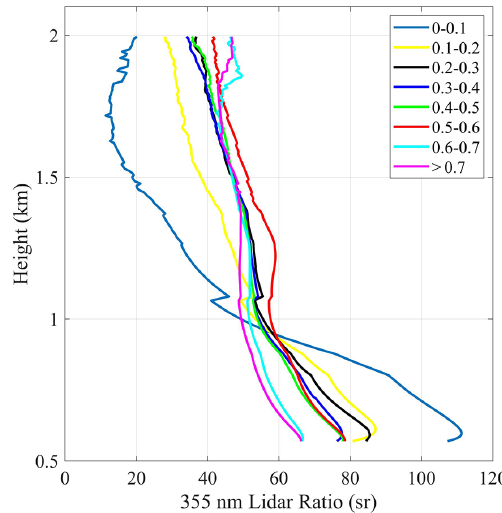
Figure 8. LR profiles in different AOD